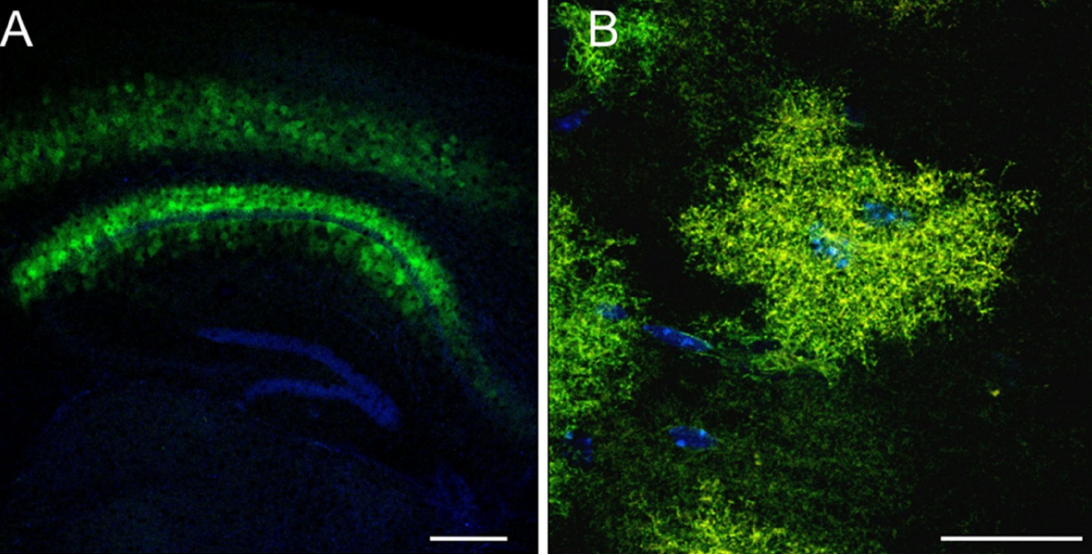
Figure 2. High-resolution confocal images of mouse hippocampal astrocytes at low (( A ), scale bar: 500 µ m) and high magnification (( B ), scale bar: 30 µ m), transduced by AAV5 viruses with a reporter gene (opto-a1AR, green) driven from the astrocytic gfaABC 1 D promoter. Nuclei are labeled with DAPI